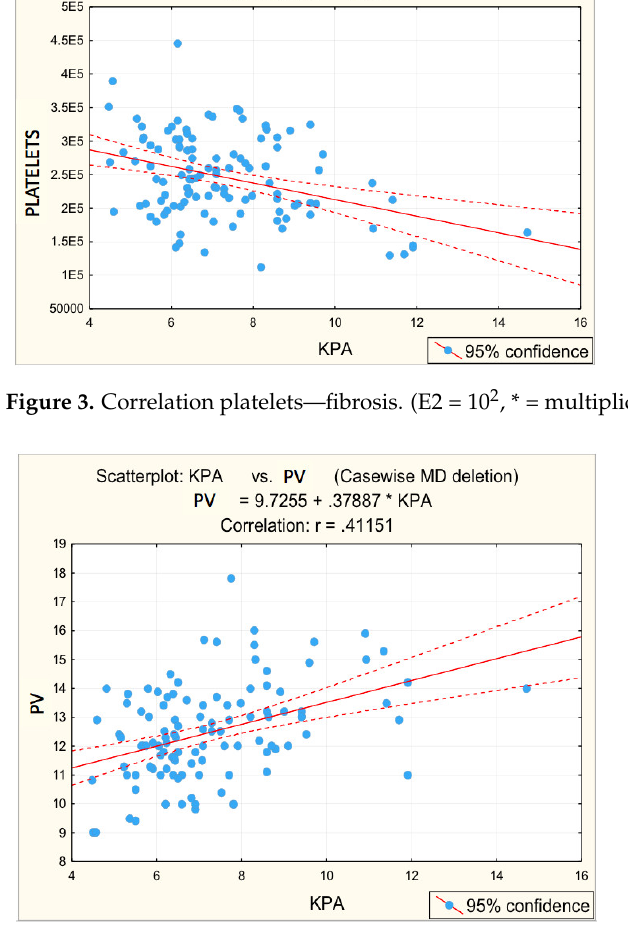
Figure 5. Correlation BSD—fibrosis .